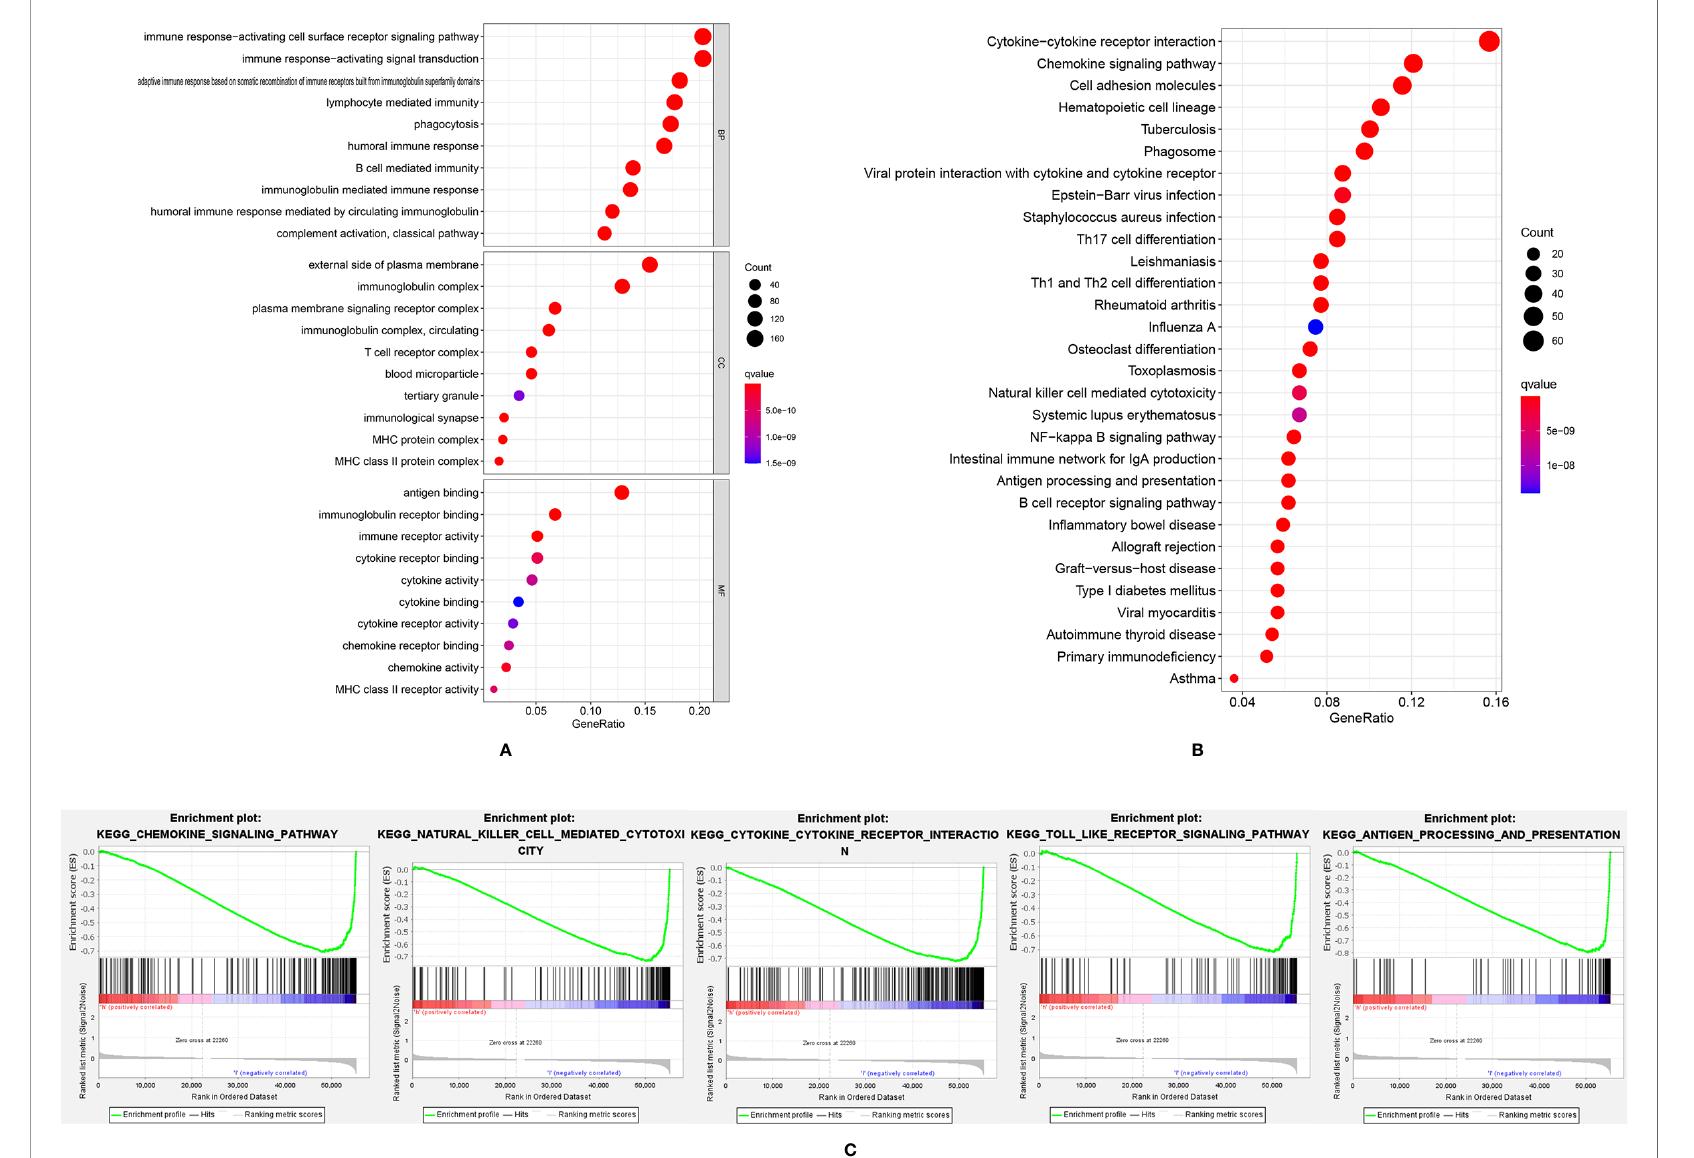
FIGURE 4 | The GO analysis (A) and KEGG analysis (B) of differently expressed genes; (C) GSEA analysis results showed immune-related pathways were highly activated in the low-risk